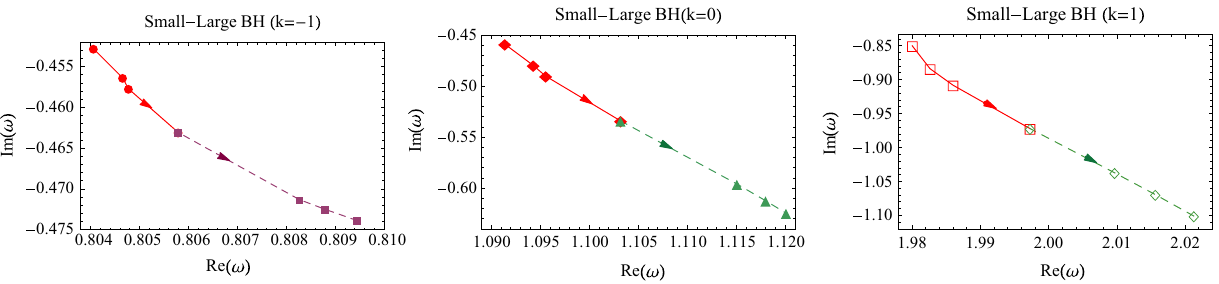
Fig. 6 The behavior of QNM frequencies for large and small black holes in the isothermal process. The arrow indicates the increase of the black hole